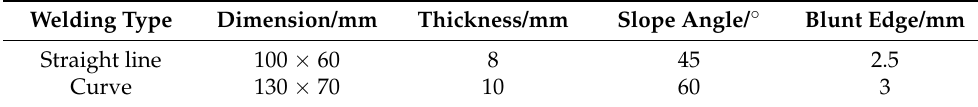
Figure 10. Two typical welding grooves for ( a ) straight line; and ( b ) curve. Table 5. Groove parameters of weldment.